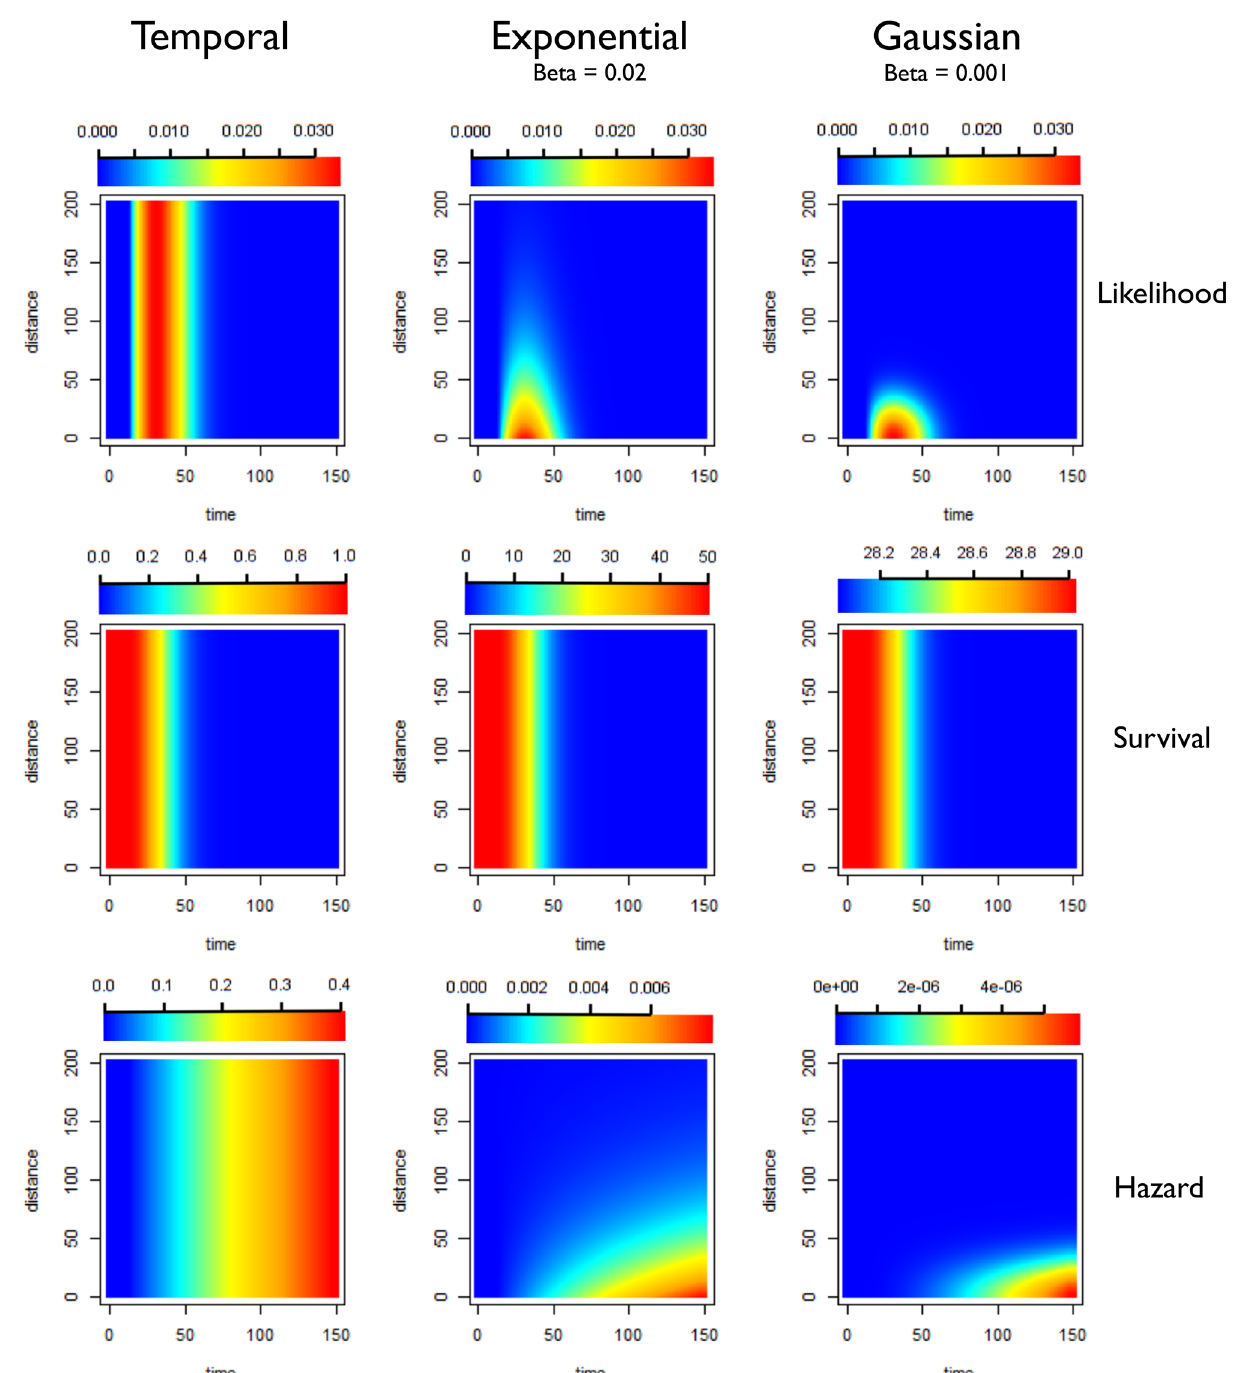
Figure 14. Illustration of likelihoods, hazards and survivals for moderately restrictive kernels (moderate human movement, most movement under 50 km). Plots showing how the pairwise likelihoods, survivals and hazards vary with time and distance under different model structures. The first row of plots shows the pairwise likelihoods, the second row shows the pairwise survival and the third row shows the pairwise hazard values for different combinations of distance (in kilometres) and time between symptom onset (days). The first column shows the results for a time-only version of the algorithm. The second column shows results for an exponential kernel and the third column shows results for a Gaussian kernel. In this example values for beta, the shaping parameter for the distance kernels have been chosen to represent a context where there is more some movement of parasites, but where little movement is expected beyond 50–75 km. The likelihood for the Gaussian Kernel is more concentrated, which could represent shorter range movement e.g. commutes, whereas the Exponential has a longer tail so could represent a mixture of short and longer range parasite